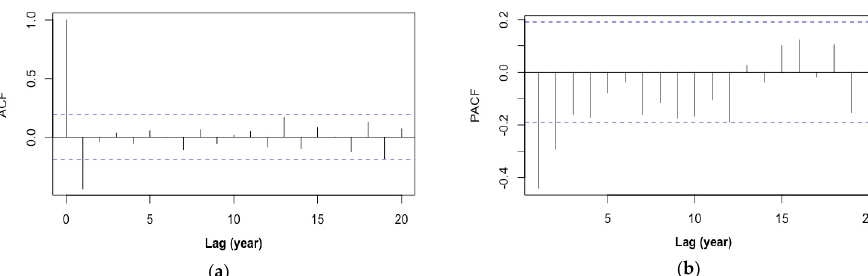
Figure 1. The annual basin-wide water supply (WS) data of the Colorado River from 1906 to 2012. To get a first impression of the correlation structure of (cid:1850) (cid:3047) , the autocorrelation function (ACF) and the partial autocorrelation function (PACF) of (cid:1850) (cid:1872) were computed (Figure 2). There appear to be a few